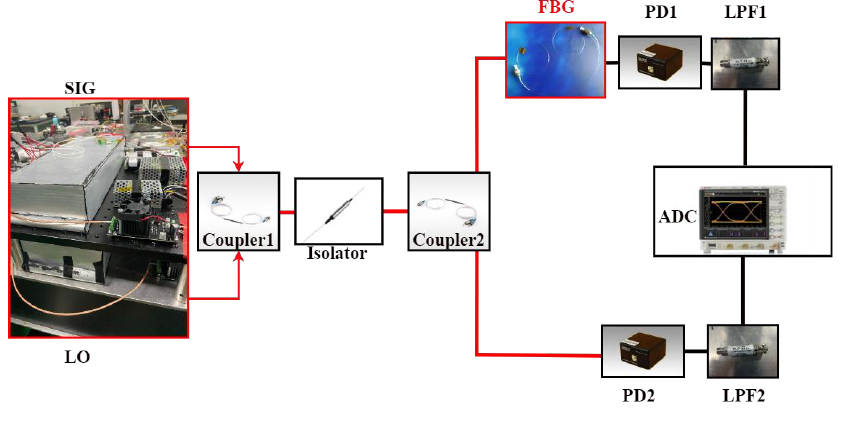
Figure 10. Real experiment system schematic.